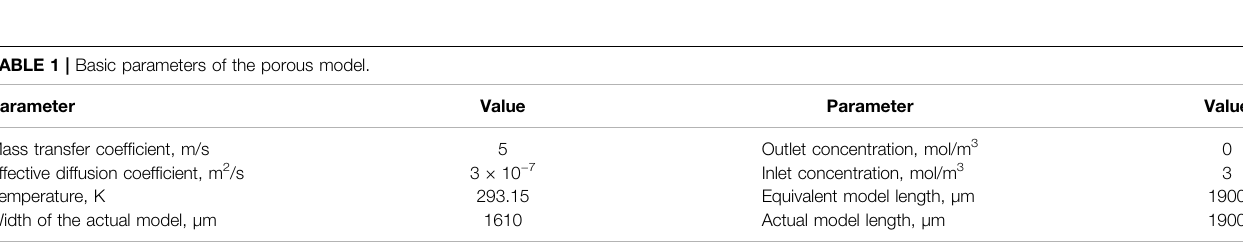
FIGURE 9 | Schematic diagram of the concentration fl ux calculation. (A) Actual model and (B) equivalent model.